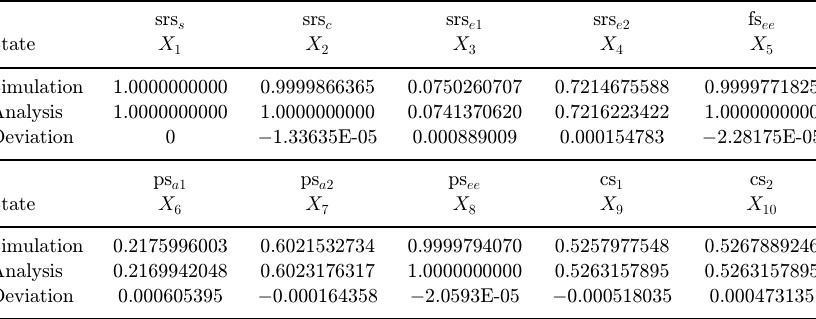
Table 6. Computing analysis and simulation (Scenario